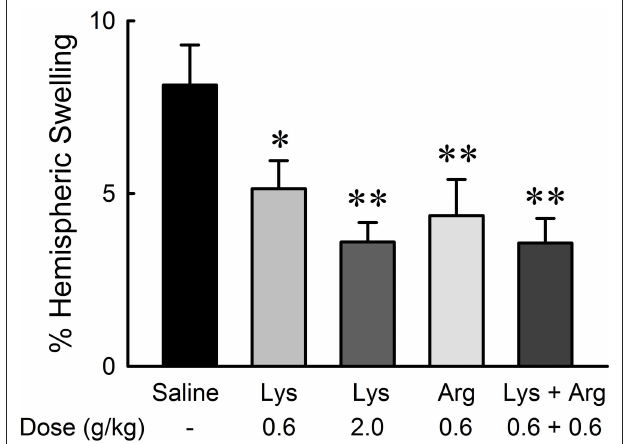
FIgure 5 | reduction of hemispheric brain swelling by oral administration of lysine (Lys) and/or arginine (Arg) in MCAO rats. Administration of lysine alone (0.6 and 2.0 g/kg), arginine alone (0.6 g/kg), or combined administration of lysine and arginine at low doses (0.6 g/kg each) significantly suppressed hemispheric brain swelling. * p < 0.05 and ** p < 0.01, significance compared to the saline-treated control group by ANOVA followed by Fisher’s PLSD